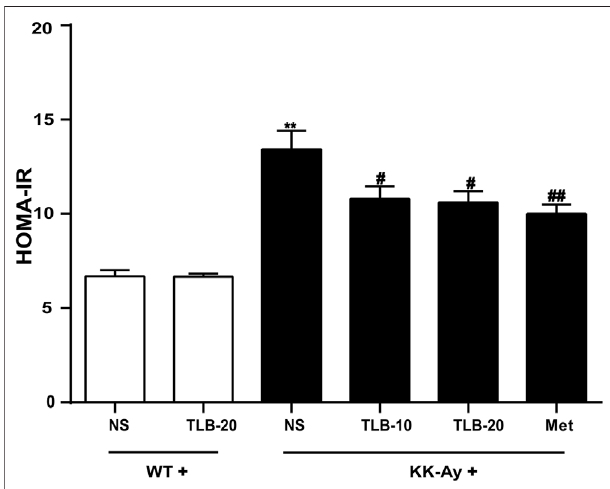
FIGURE 3 | TLB suppressed insulin resistance in KK-Ay mice. **p < .01 vs . WT group; # p < .05, ## p < .01 vs . KK-Ay group; n = 8 – 10 per group, mean ±